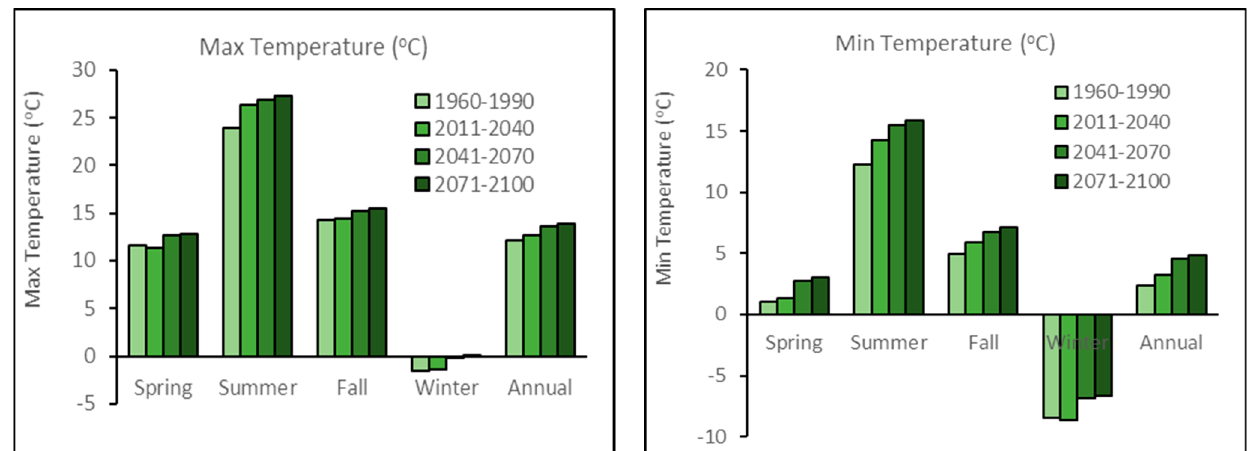
Figure 5. Historical (1960–1990) and future (2011–2100) predicted annual and seasonal mean precipitation (upper figure) and max/min daily average temperatures (lower figures) using CGCM3T47 model.